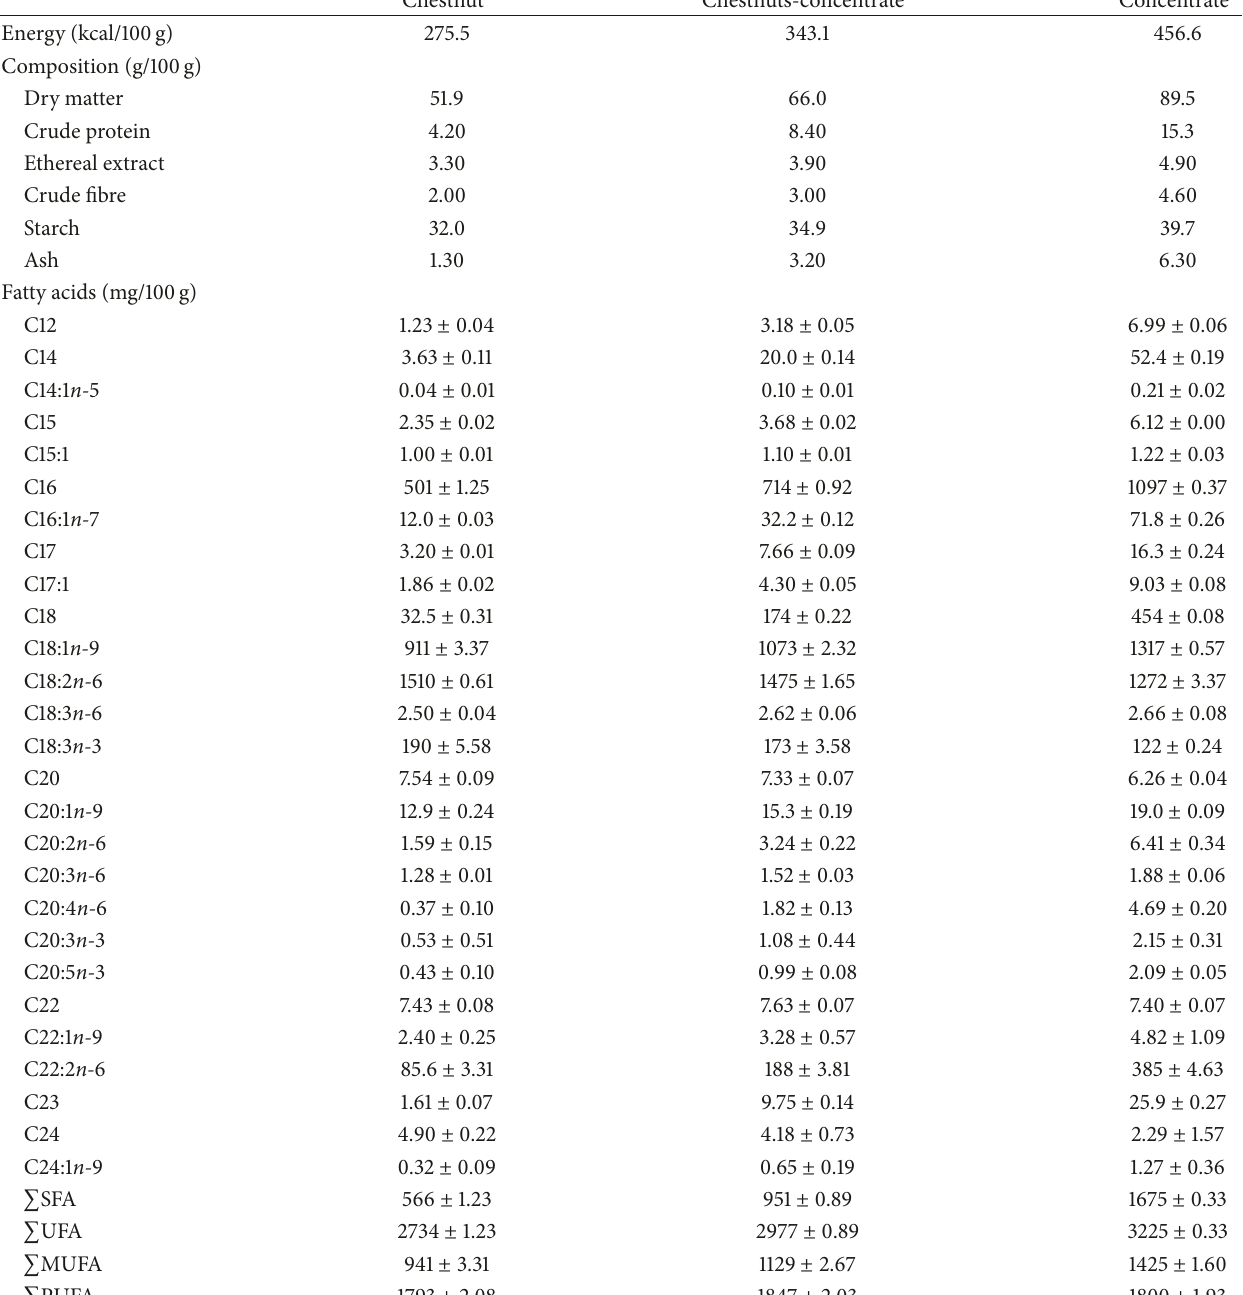
Table 1: General composition and fatty acids of the experimental diets: chestnut, mixed, and